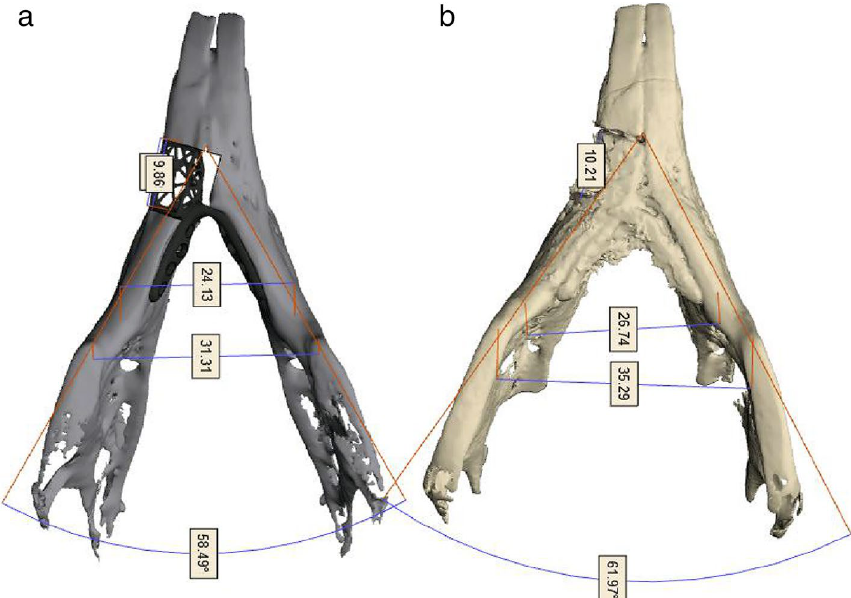
Fig. 7 Measurement of the angle between mandibular lower borders. a Angle between mandibular lower borders in the three-dimensional (3D) reconstruction image obtained preoperatively; b angle between mandibular lower borders in the 3D reconstruction image obtained